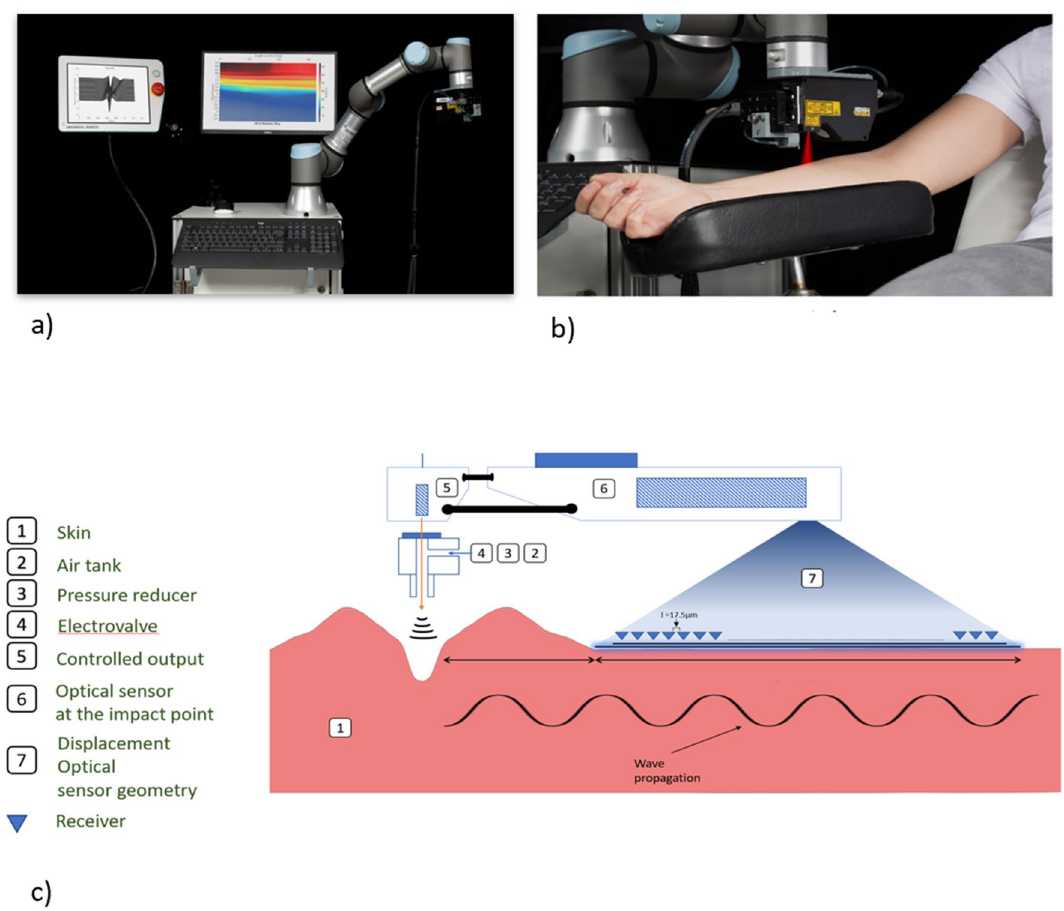
Figure 4. ( a , b ) UNDERSKIN device. ( c ) Recorded wavefield measurement